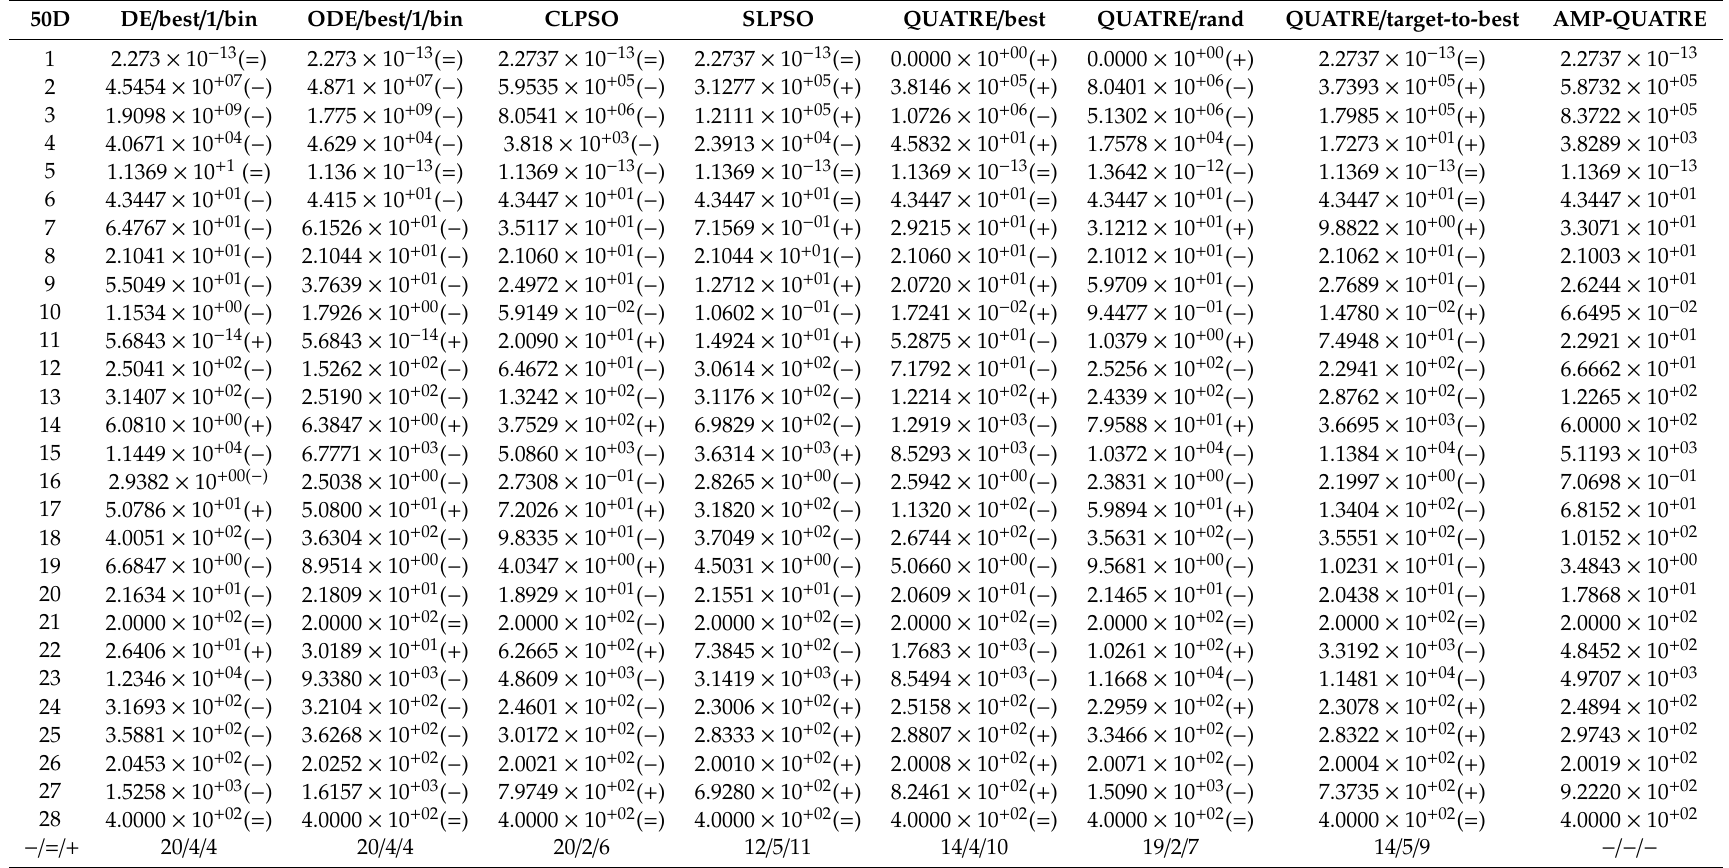
Table 3. Comparison results of best value of 20-run fitness error among contrasted algorithms under CEC2013 test